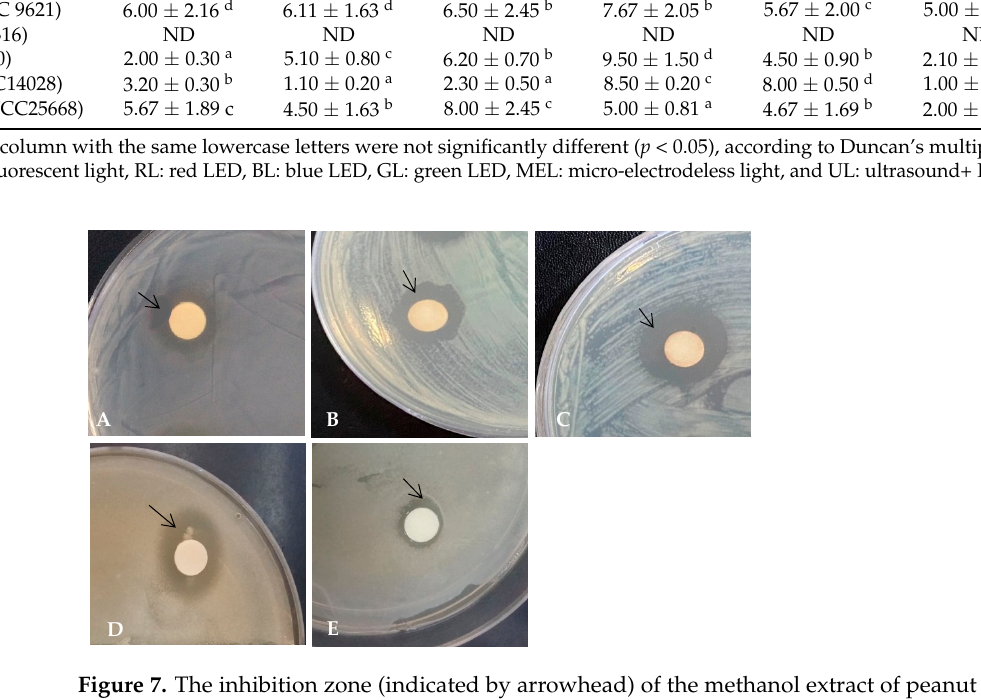
Figure 7. The inhibition zone (indicated by arrowhead) of the methanol extract of peanut sprouts grown under different light spectra. ( A ) Vibrio litoralis (KCTC12320), ( B ) Klebsiella pneumoniae subsp. pneumoniae (Schroeter) Trevisan (ATCC 9621), ( C ) Escherichia coli Castellani and Chalmers (ATCC35150, ( D ) Salmonella enteritidis serotype typhimurium Kauffmann and Edwards (ATCC14028), and ( E ) Pseudomonas aeruginosa (ATCC25668).